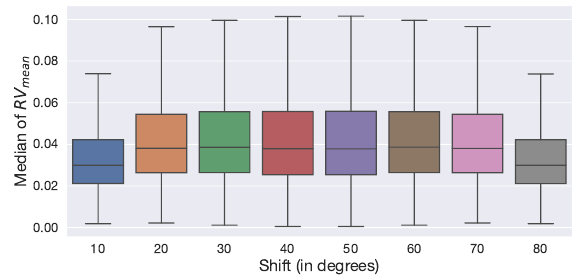
Figure 6. Impact of a shift in camera direction on the mean score when using only a 4-split, for the safety